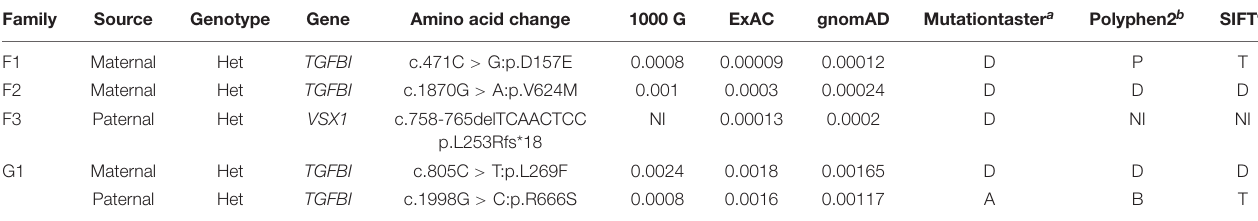
TABLE 1 | Bioinformatics data of variants identified by Sanger sequencing of the four probands.